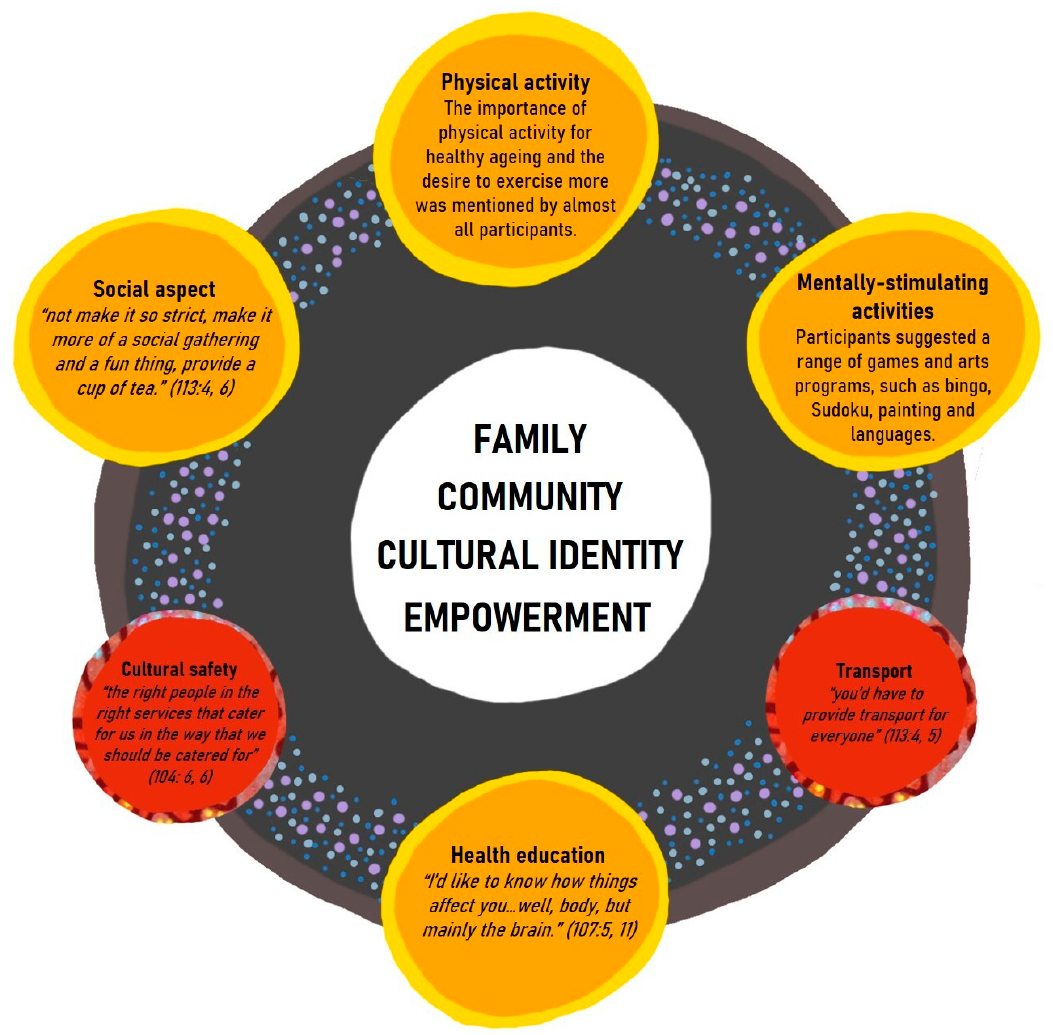
Figure 1. Model for a holistic, healthy ageing program.